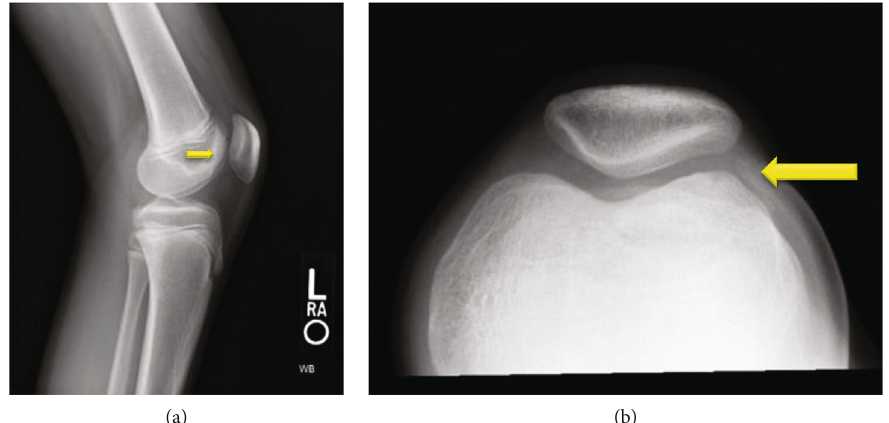
Figure 1: Initial X-rays of the patient showing osteochondritis dissecans (OCD) lesion of the lateral trochlear groove on (a) lateral and (b) sunrise views of the left